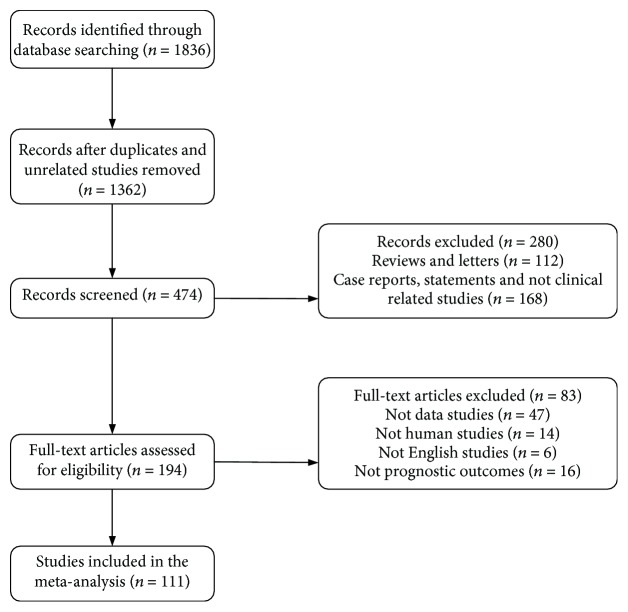
Study flow diagram.